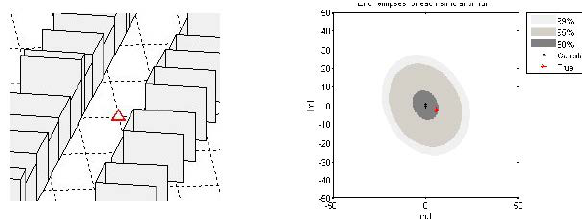
Figure 7: Street and buildings rotated to azimuth of 25 degrees (left), illustration of position error